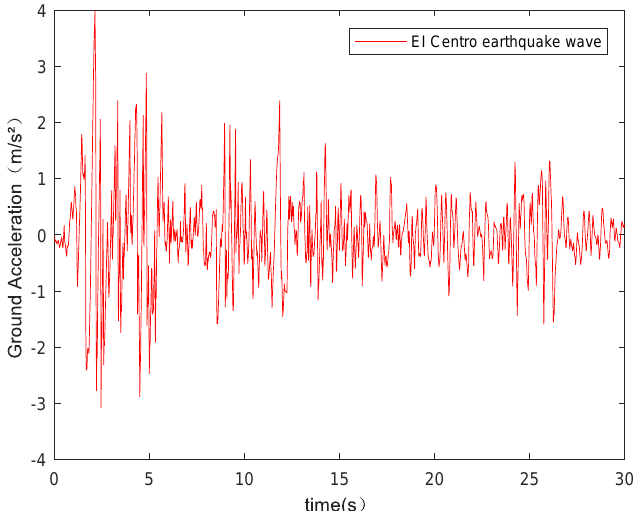
Figure 4. Earthquake seismic wave with maximum amplitude adjusted to 4 m/s 2 .